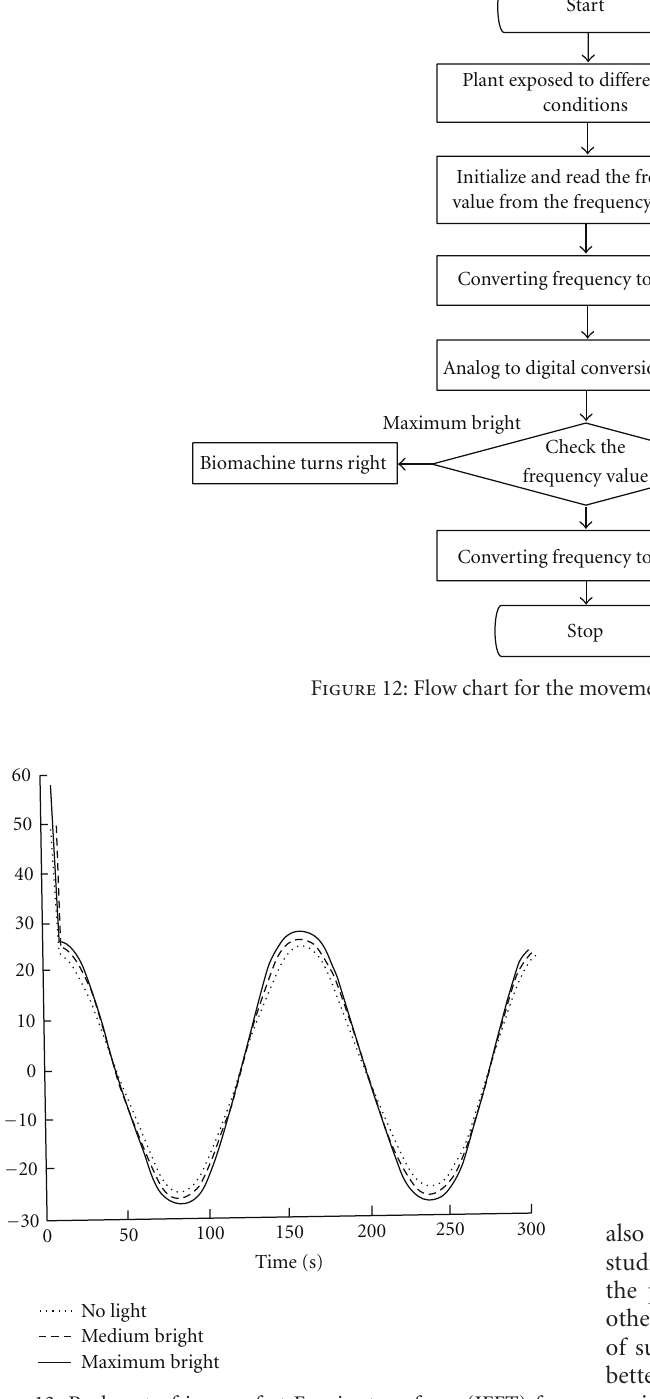
Figure 13: Real part of inverse fast Fourier transform (IFFT) for converting the frequency signal to amplitude (mV).